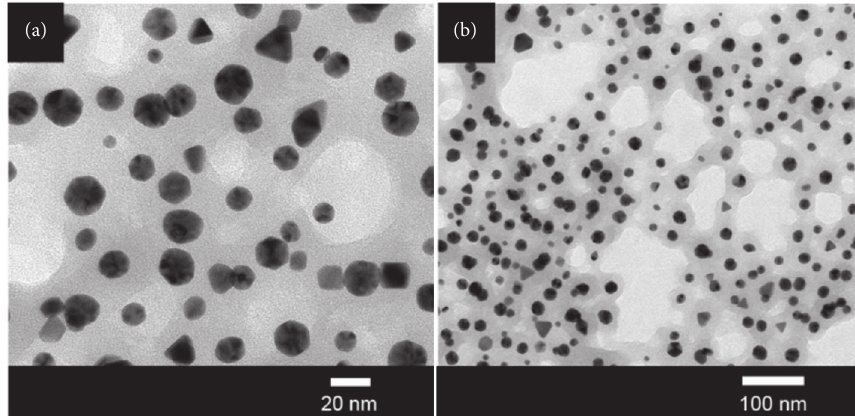
Figure 3: TEM images of AuNPs at different magnifications.